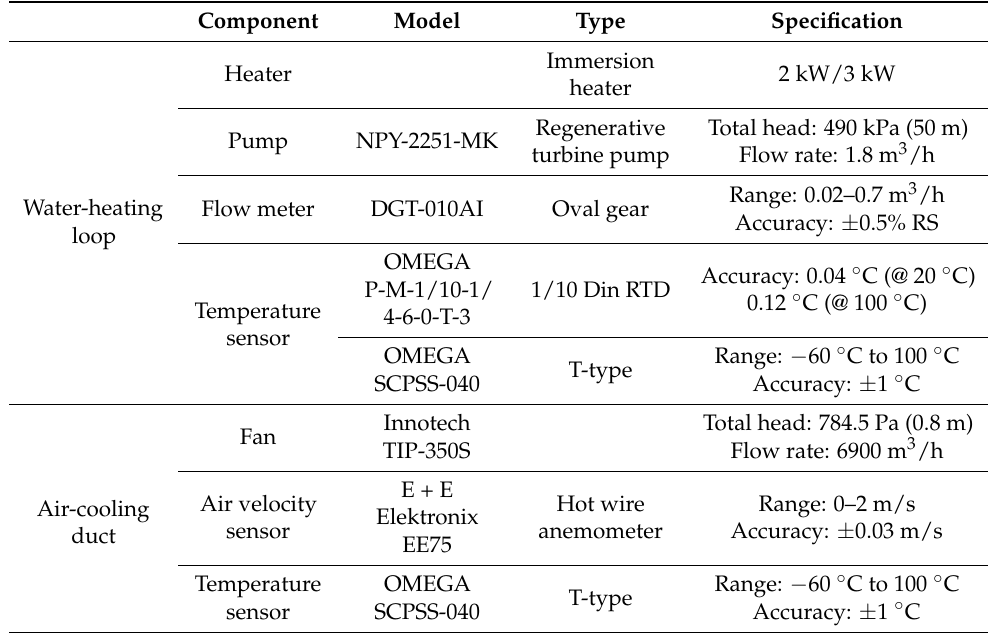
Table 1. Specifications of the major devices in the test